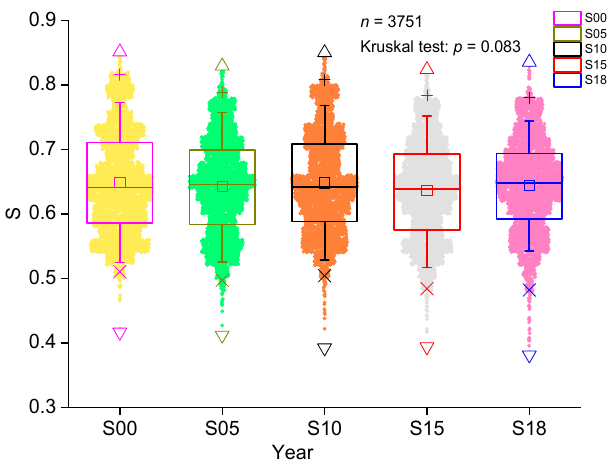
Figure 3. Variation of S from 2000 to 2018. S00, S05, S10, S15, S18 represents S of 2000, 2005, 2010, 2015, and 2018, respectively. Kruskal test method was used because of the non–normality of S ( p = 0, in Shapiro–Wilk test). S represents the ecological security index measuring the level of LES. ▽ represents minimum value; ◊ represents value of 1%; □ represents median; + represents value of 99%; △ represents maximum value.